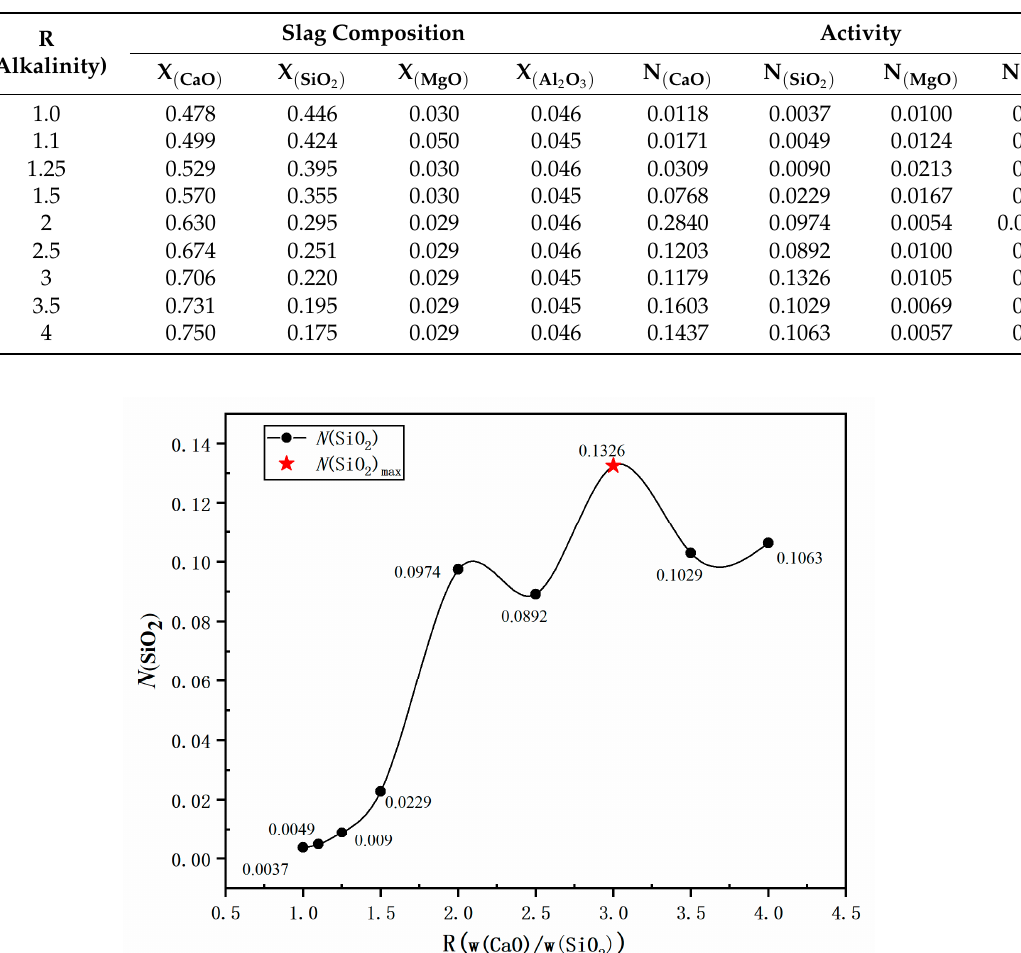
Table 4. Effect of alkalinity on the activity of components in the CaO-Al 2 O 3 -SiO 2 -MgO system.